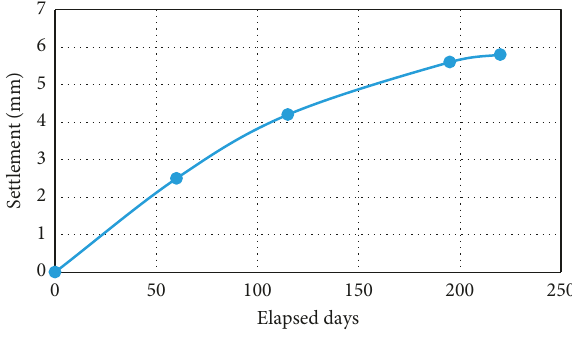
Figure 4: Surface settlement versus time. Table 2: Settlement of modified Imai’s model (mm).